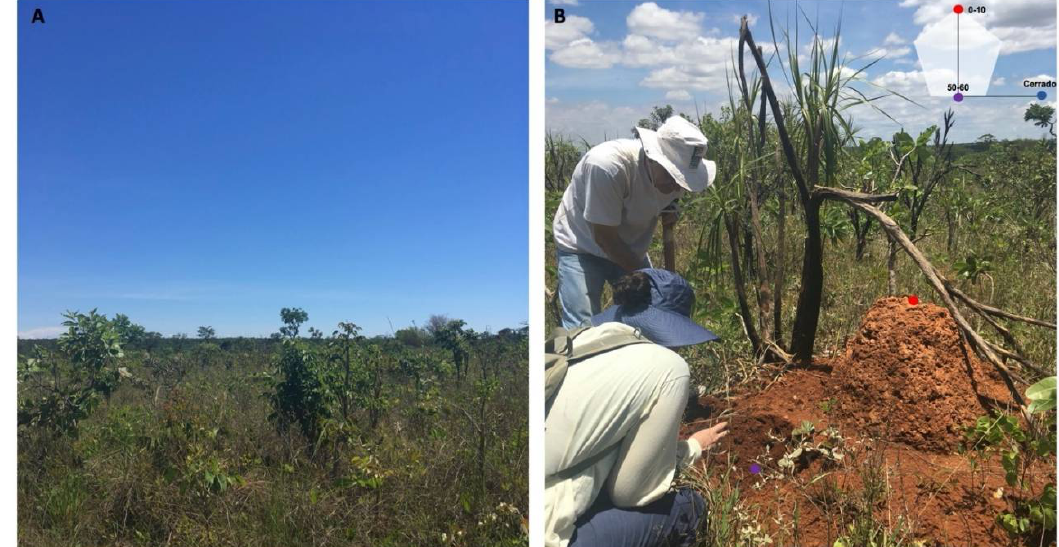
Figure 1. Site overview and sample collection. ( A ) Campo sujo in the IBGE (Instituto Brasileiro de Geografia e Estatística) Ecological Reserve during the dry season, and ( B ) Syntermes wheeleri termite mound in the campo sujo during the dry season. The red circle indicates the collection of the 0–10 cm mound surface soil samples, the purple circle indicates the collection of the 50–60 cm mound soil samples, and the blue circle indicates the collection of the control samples, or Cerrado samples, also at a depth of 50–60 cm within the soil.